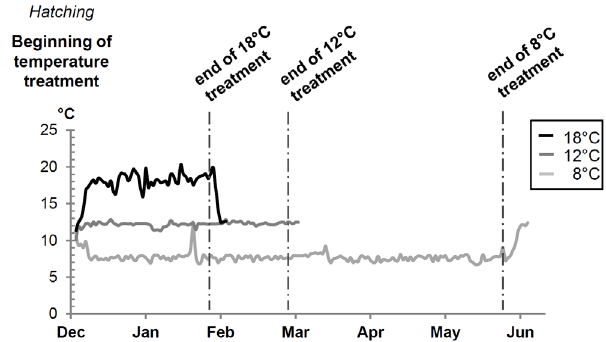
Fig. 1. Experimental conditions for the common garden experiment A. Eggs from four mal -carrying progeny were incubated at 10 ˚ C until hatching and were then shifted to the 8, 12 or 18 ˚ C temperature treatment. At first feeding, the total number of fish per progeny was reduced to 110 and all four progeny were mixed for each temperature condition. At the end of the temperature treatment, the fish were transferred and maintained at 12 ˚ C (see the Materials and Methods section for more